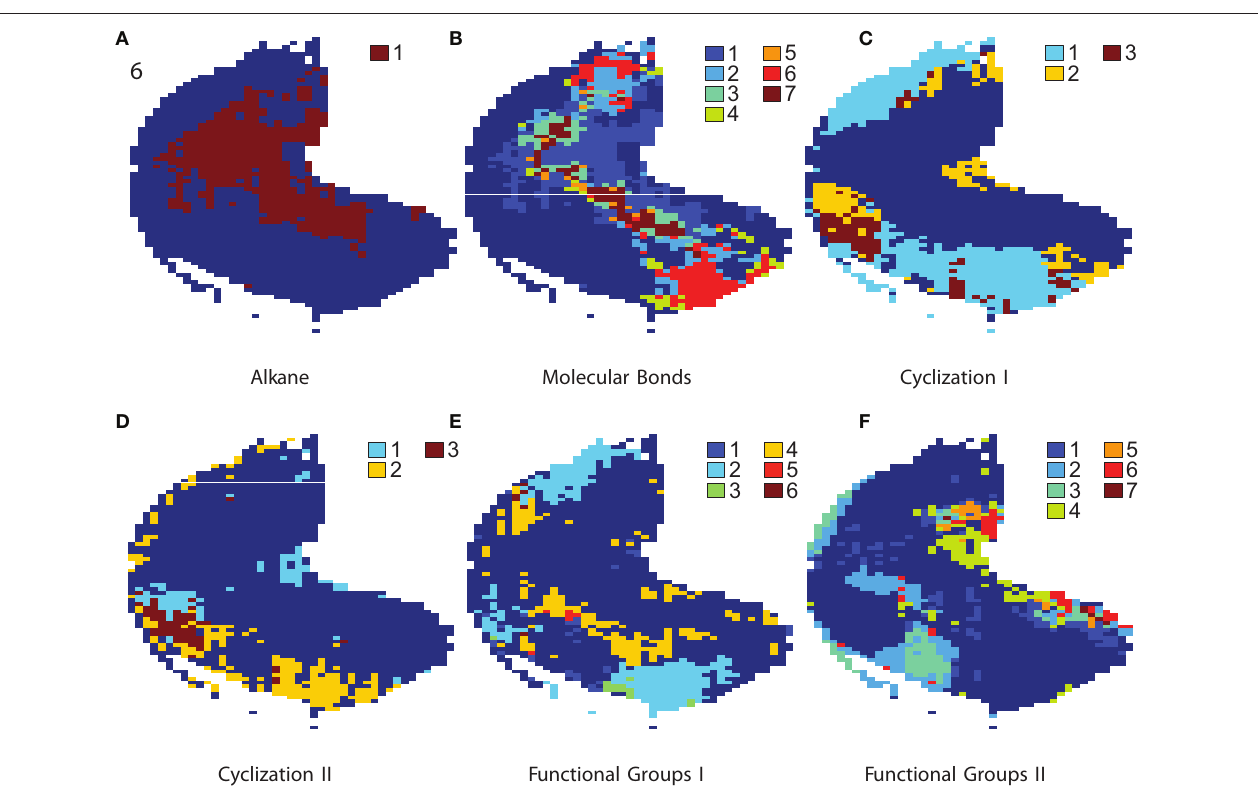
aromatic 2 alicyclic 3 aromatic and alicyclic. (D) Marks areas for two cyclization properties. The number code is as follows: 1 polycyclic 2 heterocyclic 3 polycyclic and heterocyclic. (e) Shows coding zones for three functional group properties. The numbers stand for: 1 amine 2 ketone 3 amine and ketone 4 alcohol–phenol 5 amine and alcohol–phenol 6 ketone and alcohol–phenol. (F) Indicates loci for the other 3 functional group properties. The numbers: 1 ester + lactone 2 carboxylic acid 3 ester + lactone and carboxylic acid 4 sulfur-containing compound 5 ester + lactone and sulfur-containing compound 6 carboxylic acid and sulfur- containing compound 7 ester + lactone, carboxylic acid and sulfur-containing compound. Compare to Table 1 where estimations of coding zone size are listed.